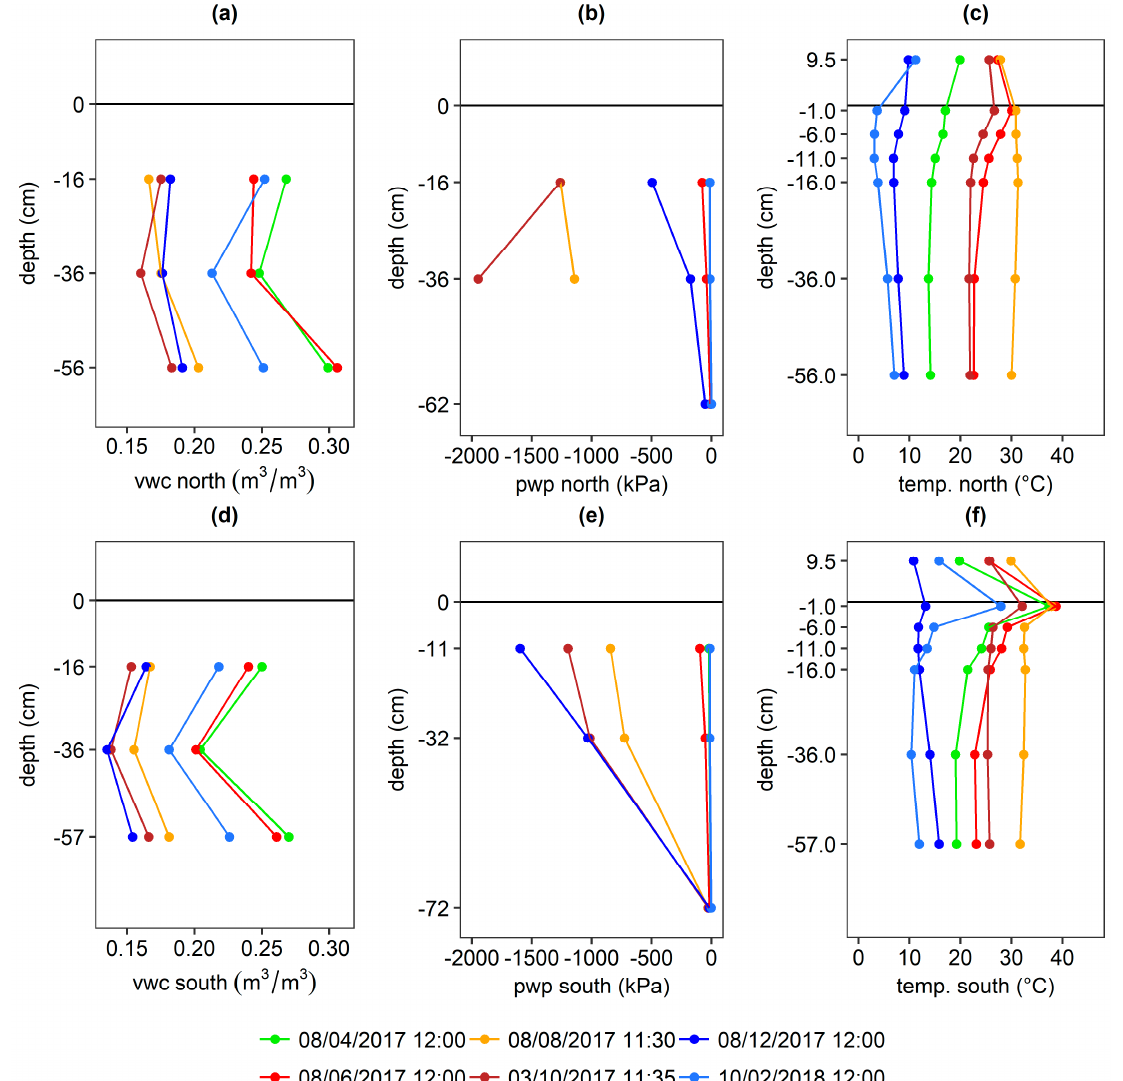
Figure 15. Temporal variation of the variations in volumetric water content (VWC), pore water pressure (PWP), and temperature (temp.) with depth at the North and South bare profiles. The data are represented in two-month intervals from April 2017–February 2018. ( a ) Volumetric water content at North slope; ( b ) pore water pressure at North slope; ( c ) air and soil temperature at North slope; ( d ) volumetric water content at South slope; ( e ) pore water pressure at South slope; ( f ) air and soil temperature at South slope.